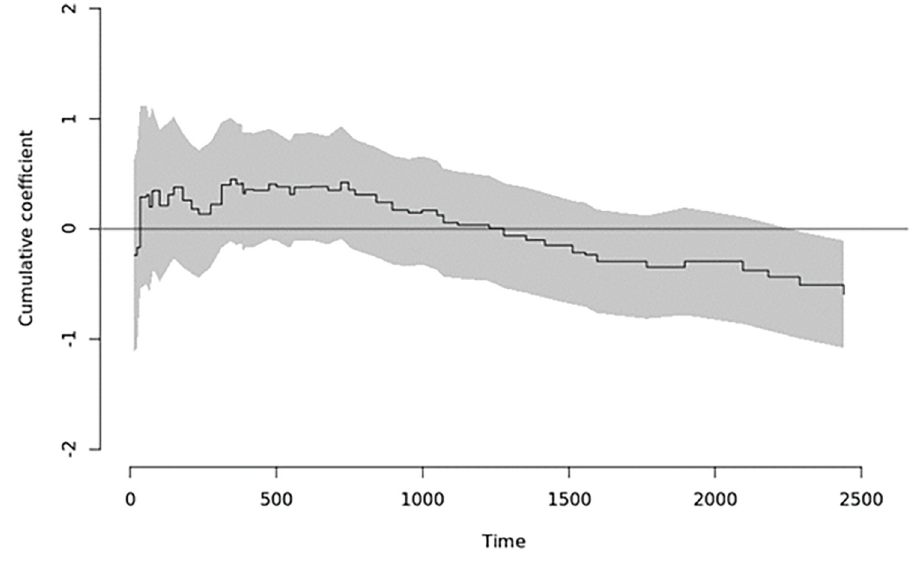
Fig 2. Unadjusted cumulative incidence of stroke and all-cause mortality by type of anti-coagulant. Overall test of curve separation p < 0.0001 for both outcomes.